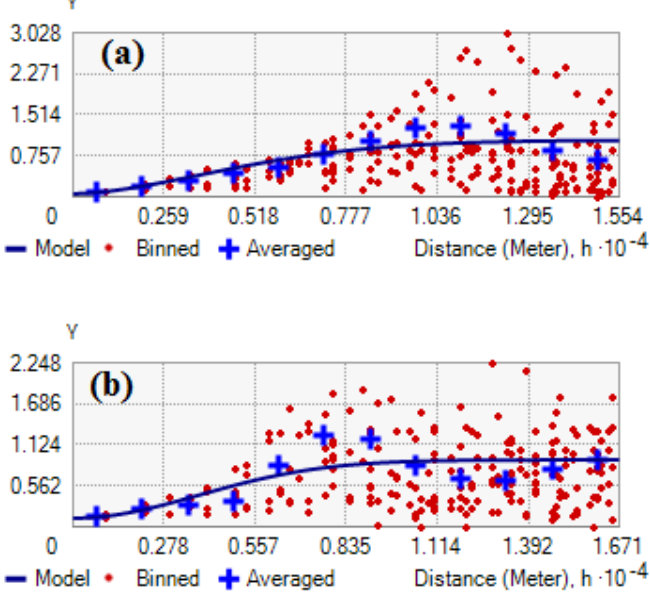
Figure 6. Result of the spatial autocorrelation of (a) the forest fire years and (b) the fire radiative power (FRP).